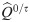
Iterative optimization to recover C from empirical Q.A Estimation based on theoretical covariances. Evolution of Q0 and Qτ errors between the model and theoretical objectives (blue curves), as well as C error between the original and model connectivity (red). The theoretical objectives Q^0/τ are calculated using Eqs (6) and (7). Errors are calculated using the normalized matrix distance in Eq (25). The optimization relies on Eq (15) with time shift τest = 1 s. B Details of the match of the model and objective matrices for Qτ (blue dots) and C (red crosses) at three stages of the optimization in A. The black line indicates a perfect match. C Similar plot to A with empirical Q as objectives, evaluated using Eq (2) for 50 simulations of the same network as in A. D Similar plot to B for the optimization in C.